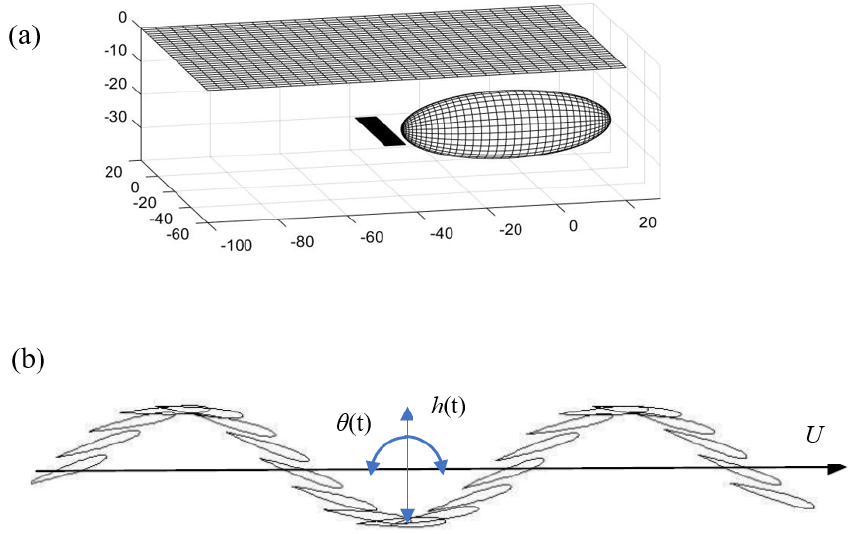
Figure 1. ( a ) Flapping thruster used for the propulsion of an AUV or small ocean vehicle. ( b ) Consecutive positions of foil oscillatory motion due to combined heaving h ( t ) and pitching θ ( t ) motion. The unsteady forces lead to the generation of oscillatory vertical lift force F z ( t ) and horizontal thrust force F x ( t ) with a significant non-zero mean (blue arrow in Figure 1).